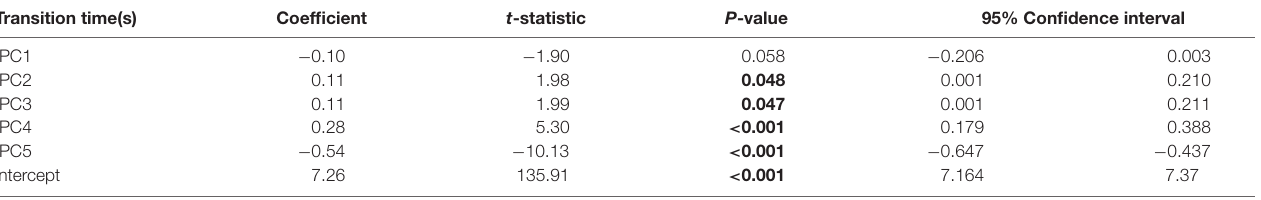
Adjusted R 2 = 0.05, p-values < 0.05.